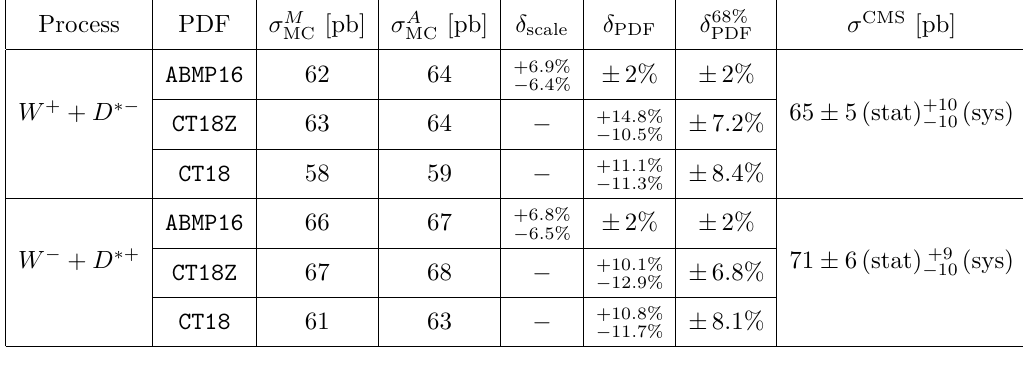
Table 2 . Our predictions for the integrated fiducial NLO + SMC cross sections of W + + D ∗ (2010) − √ and W − + D ∗ (2010) + productions according to the CMS analysis at s = 13 TeV of ref. [22]. PS, hadronization, MPI and beam remnant effects are accounted for using either the PYTHIA8 Monash tune (third column) or the ATLAS A14 central tune (fourth column). Also reported, for the simulations with the Monash tune, are the uncertainties stemming from scale variation, computed using the AMBP16_3_NLO PDF set, and the internal uncertainties related to each PDF set considered. The column denoted as δ 68% reports symmetrized PDF uncertainties at PDF